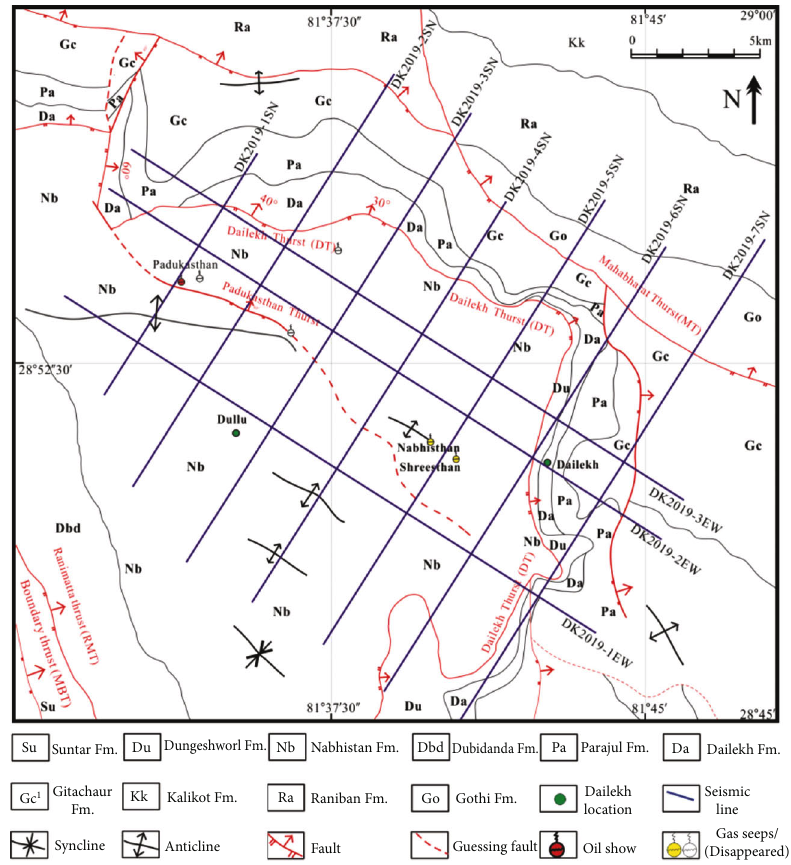
Figure 2: Geological map of Dailekh district showing main stratigraphic units, structures, seismic surveying lines, and oil and gas seeps (rock type of formation or group is described in Table 1).